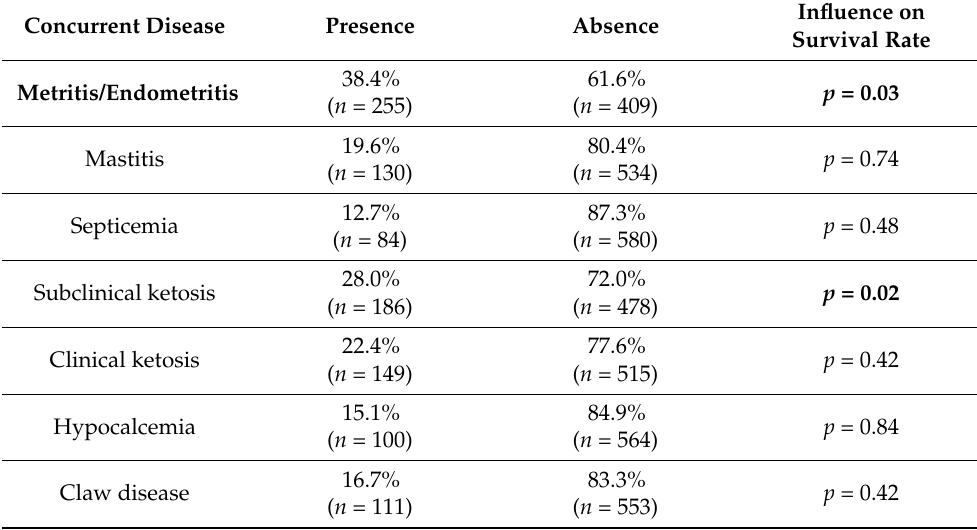
Table 5. Distribution of concurrent diseases in 664 cows diagnosed with left displacement of the abo- masum (LDA). Subclinical ketosis was defined as betahydroxybutyrate from 1.2 to 2.99 mmol/L [18], and clinical ketosis as betahydroxybutyrate > 2.99 mmol/L [18]. Due to the retrospective nature of the study, retained fetal membranes, metritis, and endometritis were counted as one disease, as were the different forms of mastitis (given as mastitits), and claw pathologies, indicated as claw diseases. Death or recovery were considered as survival rate. Results with a p -value < 0.05 were considered statistically significant and are printed in bold letters.